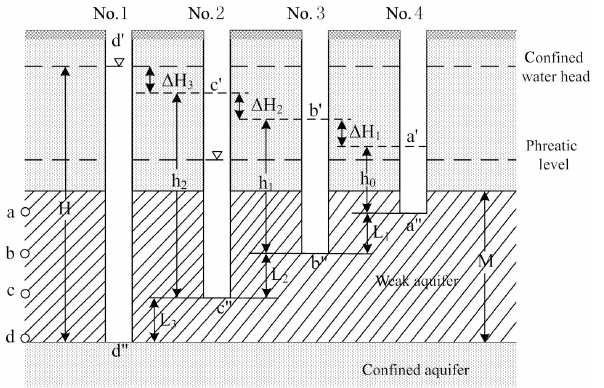
Figure 2. Schematic diagram of overflowing replenishment to solve I 0 for a confined